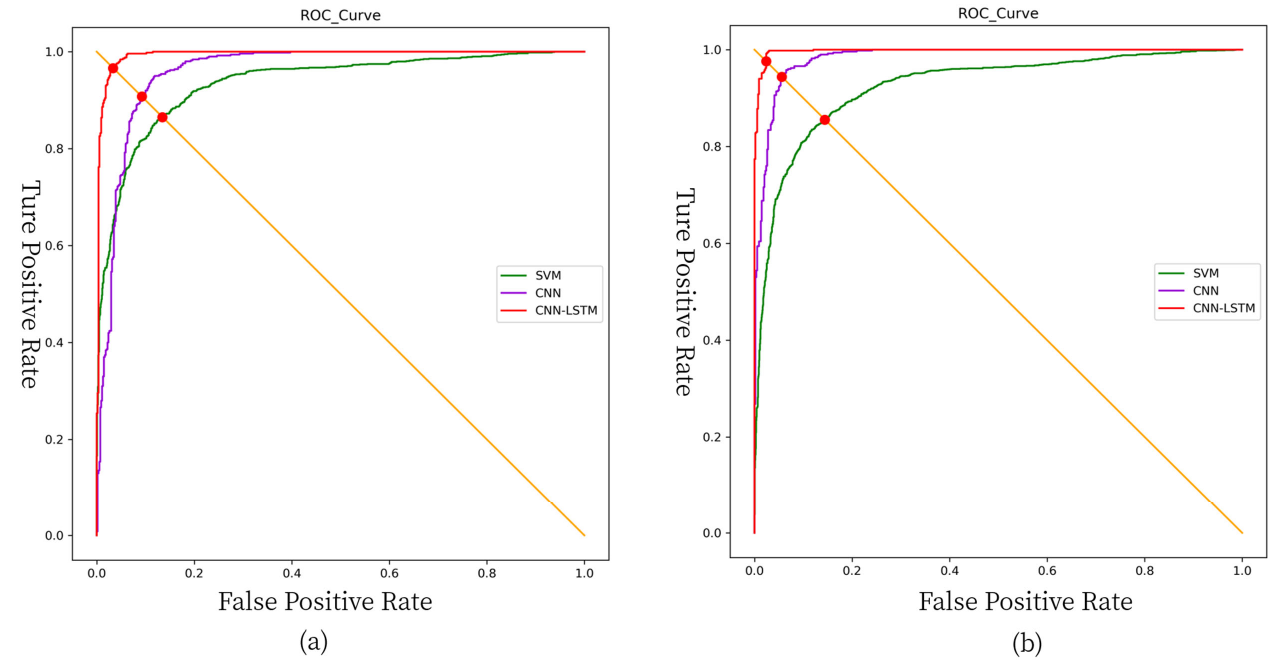
Figure 17. ROC curves: ( a ) the ROC curves of the three types of models when the number of training sets is 2000; ( b ) the ROC curves of the three types of models when the number of training sets is